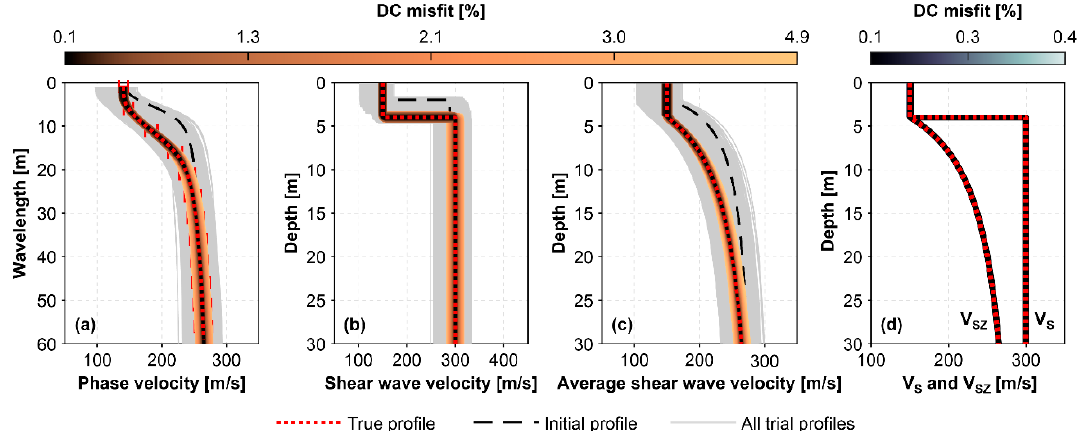
Figure 4. Inversion of the unperturbed synthetic dispersion curve from model A. A two-layer geologic structure was assumed with the layer interface initially positioned at a depth of 2 m. The search-control parameters were specified as b = 10. ( a – c ) Profiles whose dispersion curves deviate less than 5% from the synthetic curve at all wavelengths [color scale based on dispersion curve (DC) misfit values]. The background gray areas display all sampled models. ( d ) Lowest DC misfit V S - and V SZ -profiles within each independent set of 1000 iterations (10 profiles).